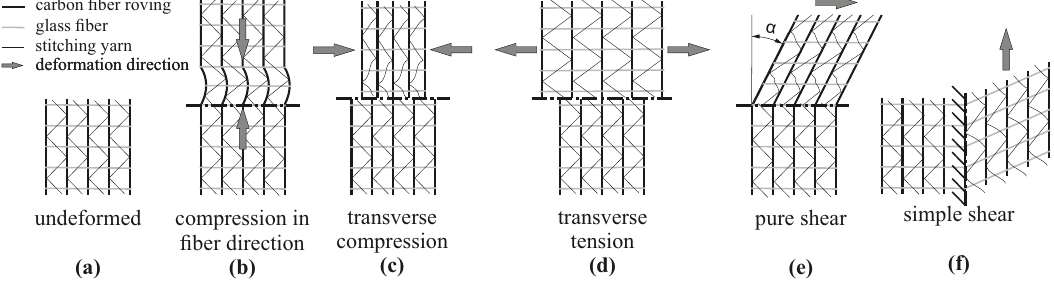
Figure 1. Schematic representation of different deformation modes of a dry unidirectional non-crimp fabric (UD-NCF)